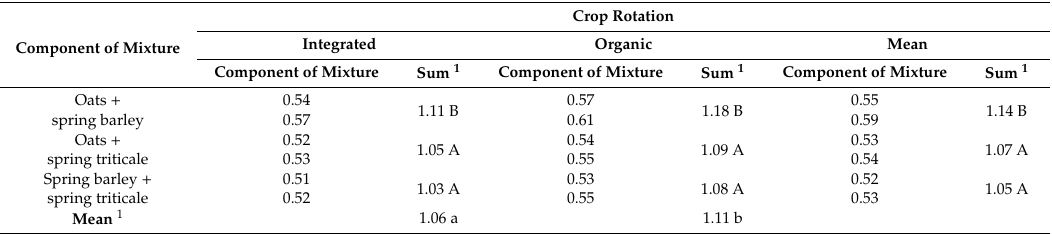
Table 8. Values of land equivalent ratio (LER) for the components of the spring cereal mixtures in integrated or organic crop rotations, means for the years